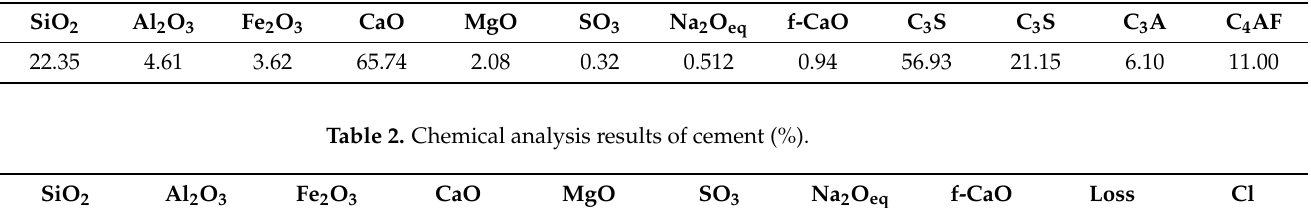
Table 1. Chemical analysis results and mineral composition of reference cement clinker (%).